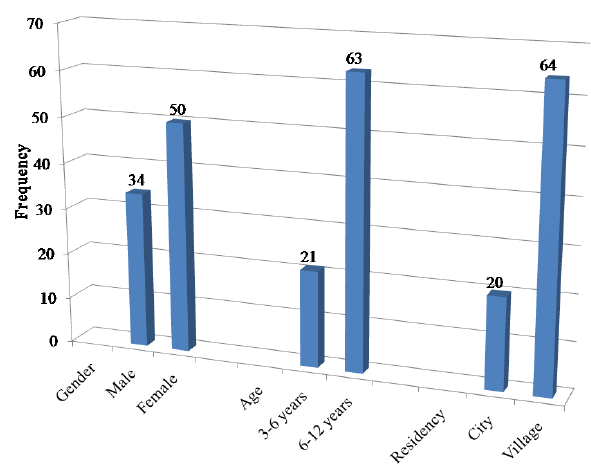
Figure 3. Demographic characteristics of the sample.